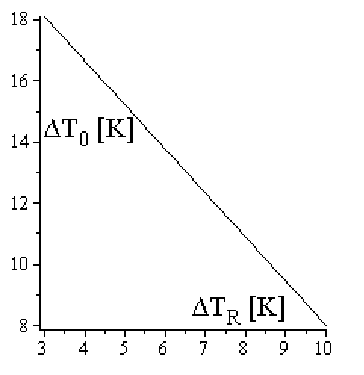
Figure 7. Δ T C dependence of Δ T H —case “c”.